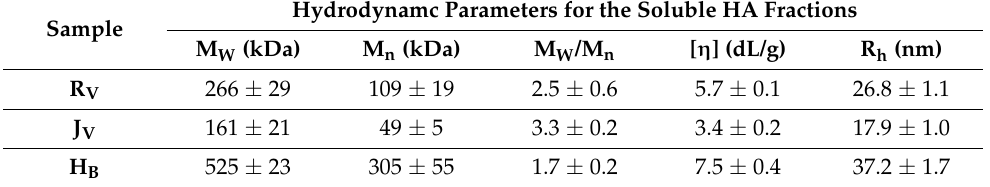
Table 2. Weight average molecular weight (M w ), numeric average molecular weight (M n ), polydis- persity index (M w /M n ), intrinsic viscosity ([ η ]) and hydrodynamic radius (R h ). Sample